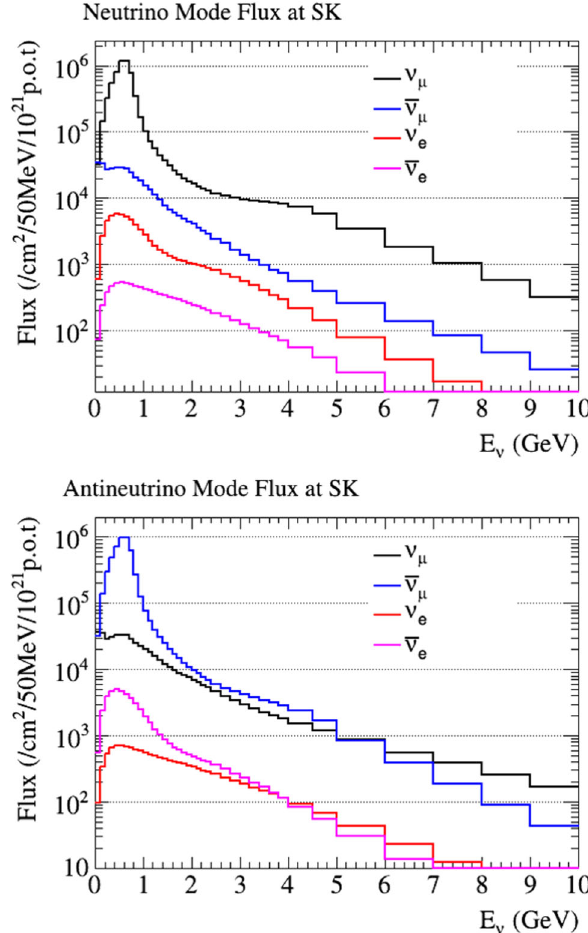
Fig. 54 PredictionoftheT2Kfluxforneutrinos(top)andantineutrinos (bottom) at SK [56]. The flux above E ν = 10 GeV is not shown; the flux is simulated up to E ν = 30